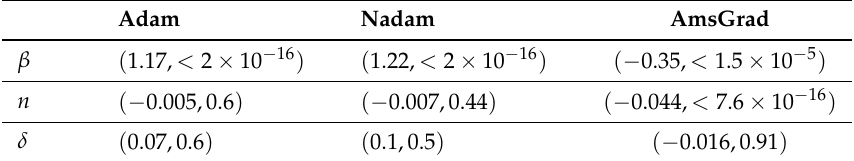
Table 3. Logistic regression coefficients and corresponding p